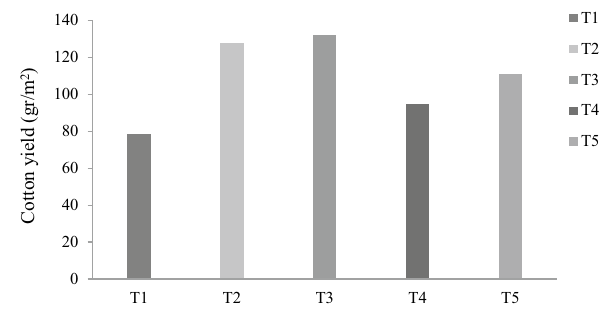
Fig. 7 Cotton yield in research